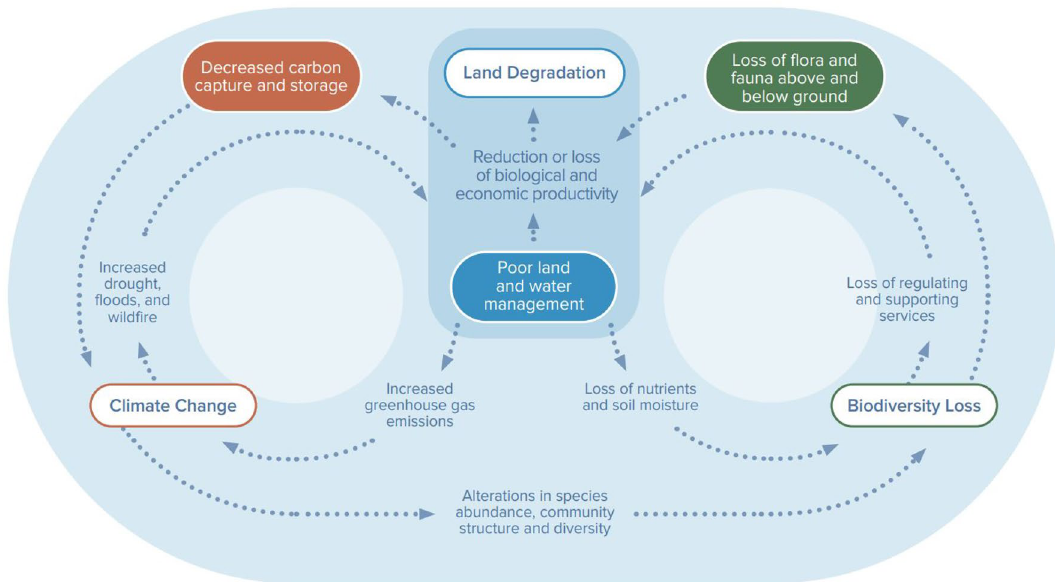
Figure 1. Feedback loops between land degradation, climate change, and biodiversity loss. Taken from Figure 1.3 in The Global Land Outlook UNCCD (2022) 19